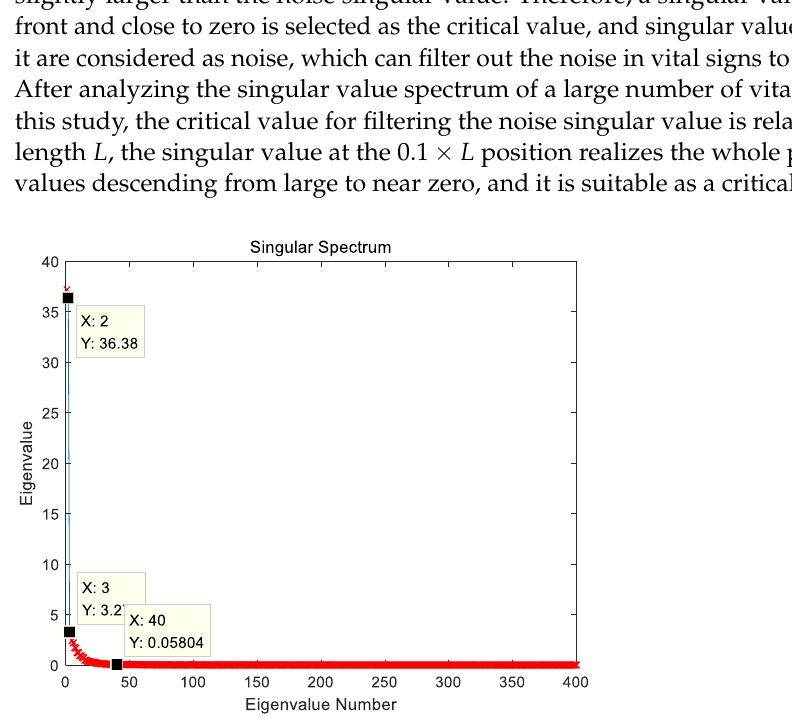
Figure 9. SSA reconstruct vital sign.